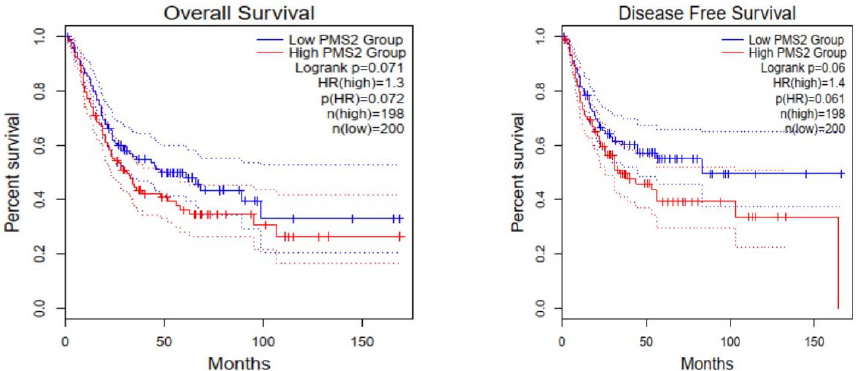
Figure 6. Cases with low PMS2 expression levels are characterized by longer overall survival (OS) and disease-free survival (DFS); however, this correlation is not statistically significant ( p -values 0.071 and 0.06, respectively).